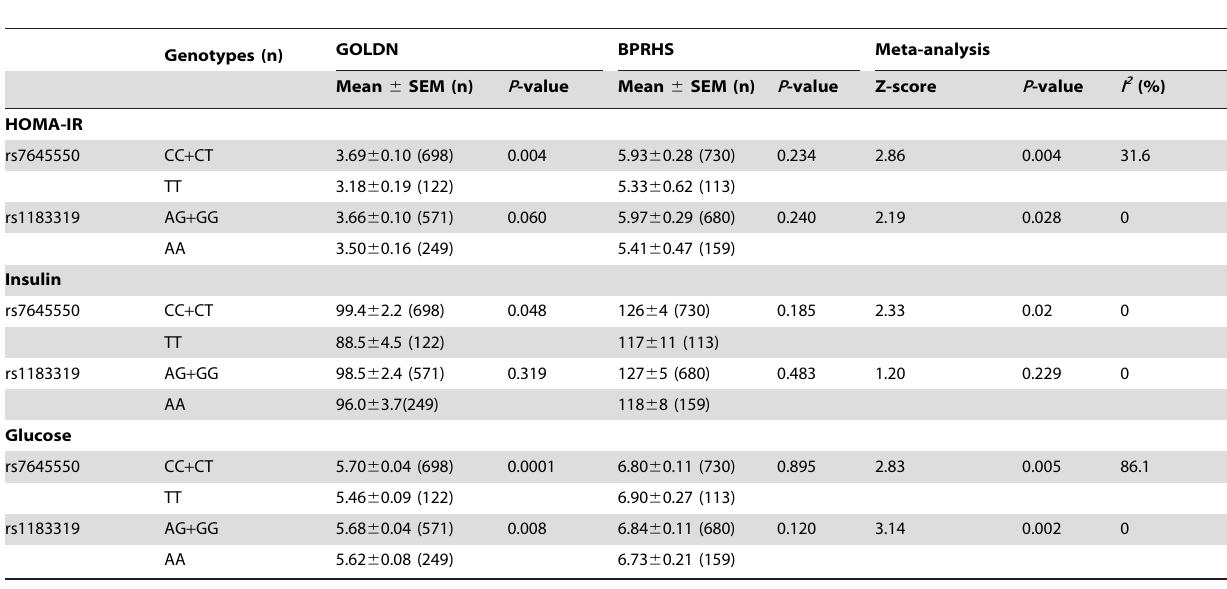
Table 2. Associations between PIK3CA-KCNMB3 variants and glucose-related traits in the GOLDN and BPRHS participants 1 .